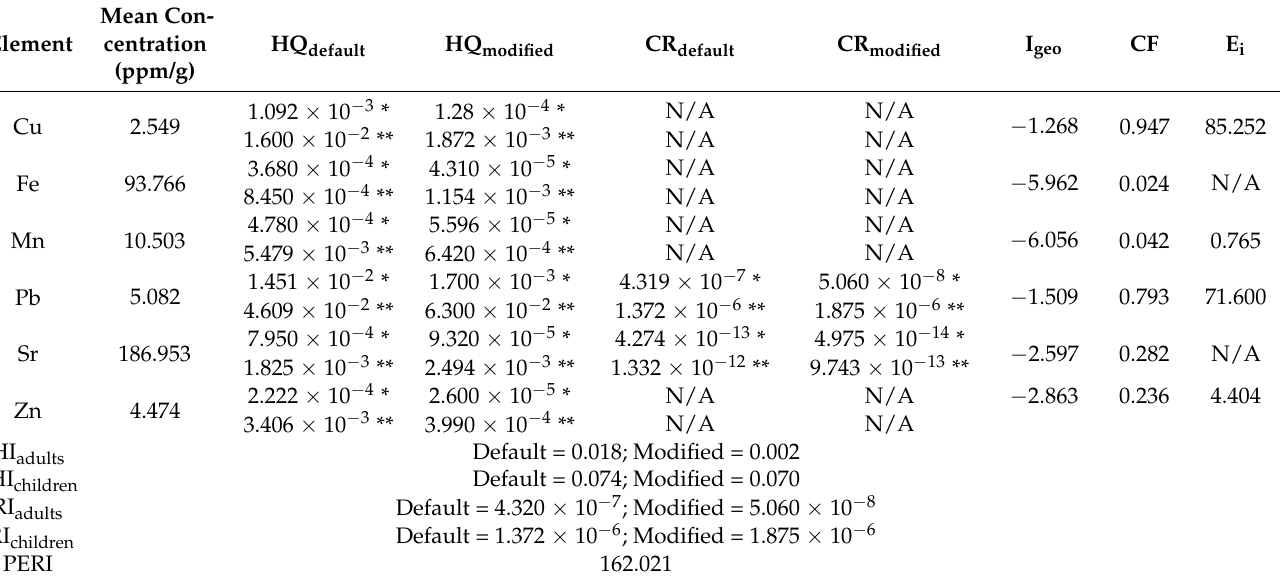
Table 10. Results for the Health Risk Assessment and the Potential Ecological Risk Assessment